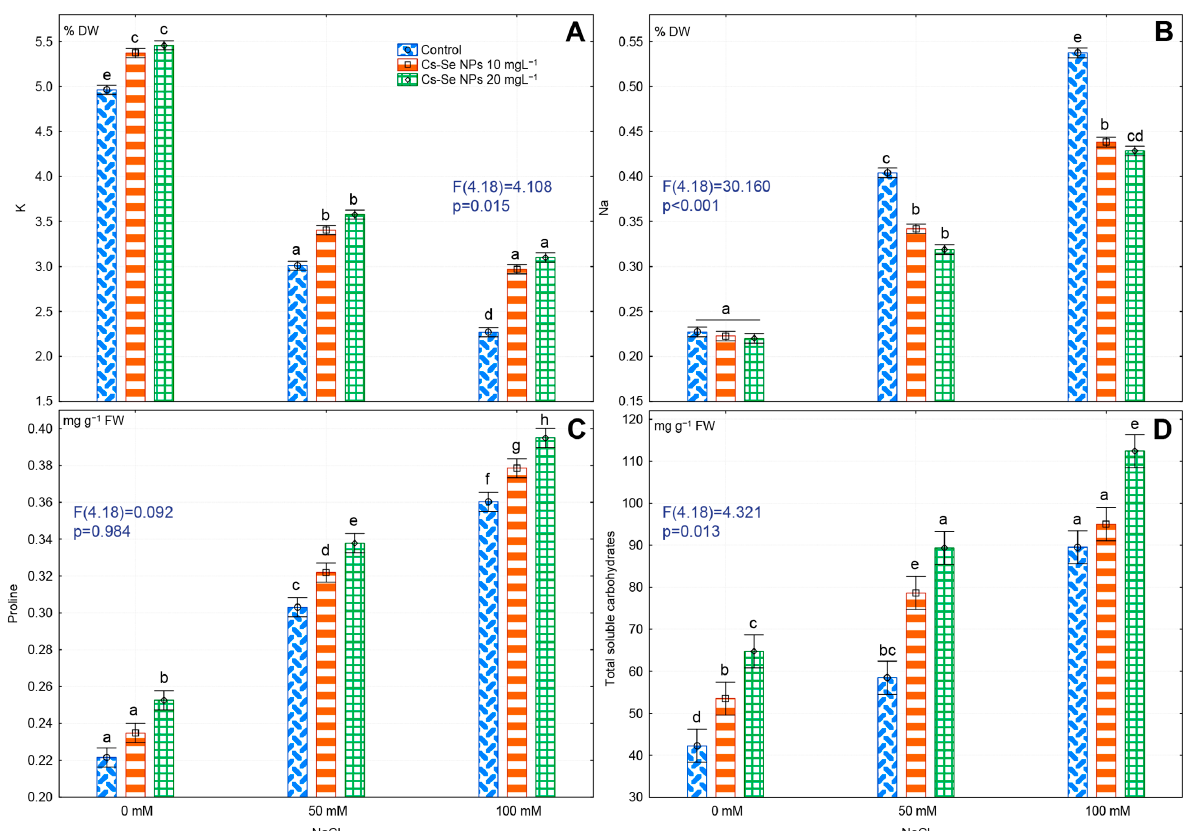
Figure 2. Effect of increasing concentration of Cs–Se NPs on K + ( A ), Na + ( B ), proline ( C ) and total soluble carbohydrate ( D ) content of bitter melon ( Momordica charantia ) leaves under salinity stress. The SDs denoted by lower-case letters in the same treatment indicates significant differences at p < 0.05 according to Tukey’s post hoc test.